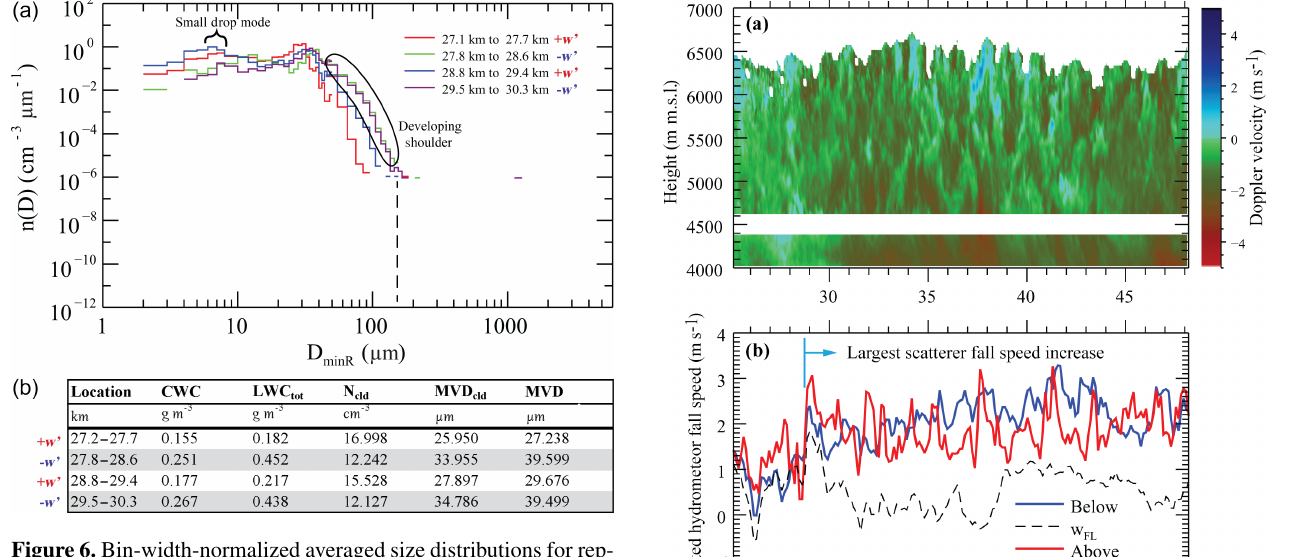
Figure 6. Bin-width-normalized averaged size distributions for rep- resentative perturbation updrafts and downdrafts within the flight- level-sampled SCVVF train from leg 1. Table (b) contains calcu- lated distribution parameters for the curves shown in (a) . The corre- sponding location downwind of Packer John is given in the legend in (a) .